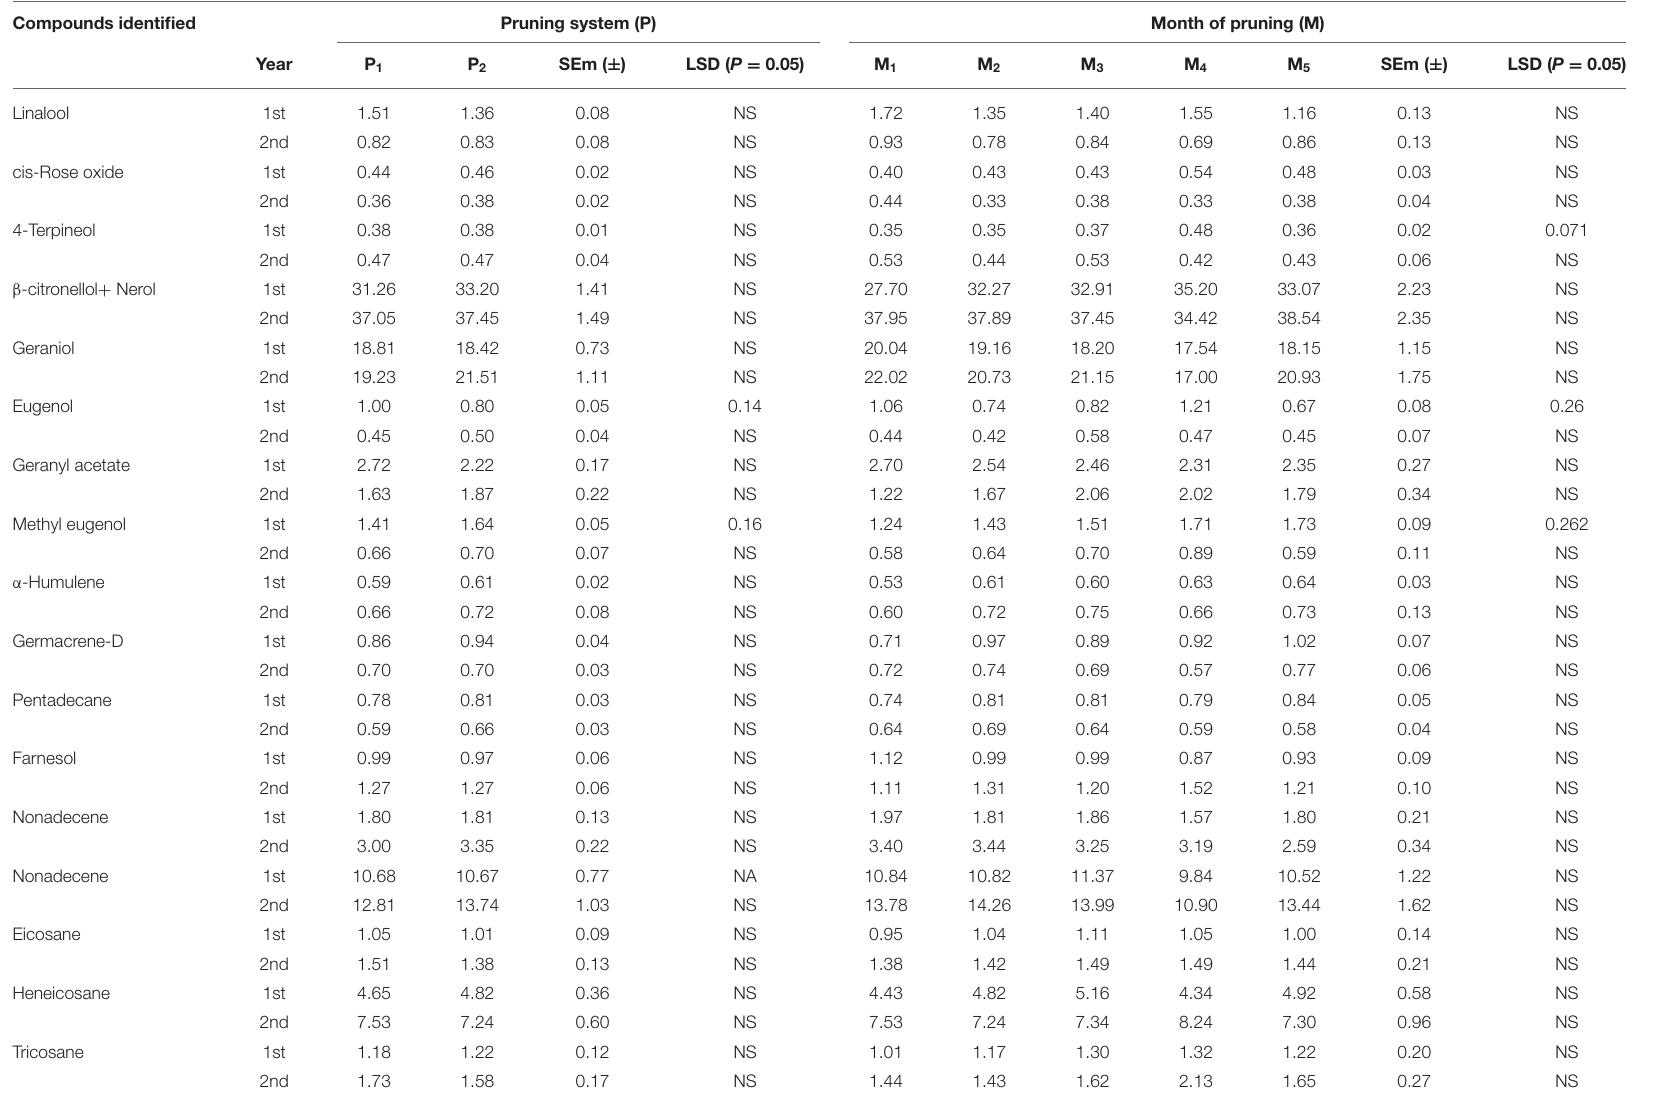
TABLE 3 | Variation in essential oil composition of R. damascena due to pruning system (P) and month of pruning (M). Compounds